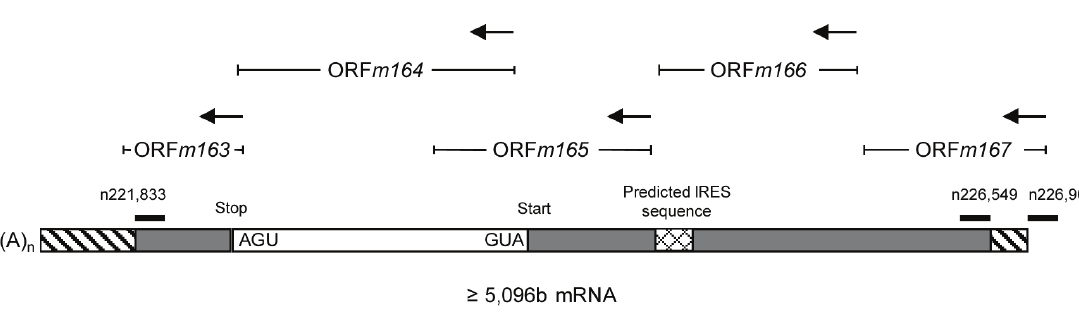
Figure 6. Provisional map of the >5 kb m164 IE mRNA and its localization within the mCMV genome. Positions of oligonucleotides binding inside or outside of the IE transcript are shown. Unmapped sequences are indicated as hatched boxes. A predicted IRES is